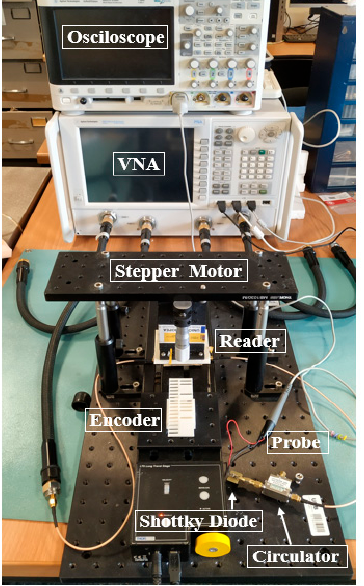
Figure 5. Photograph of the experimental setup.